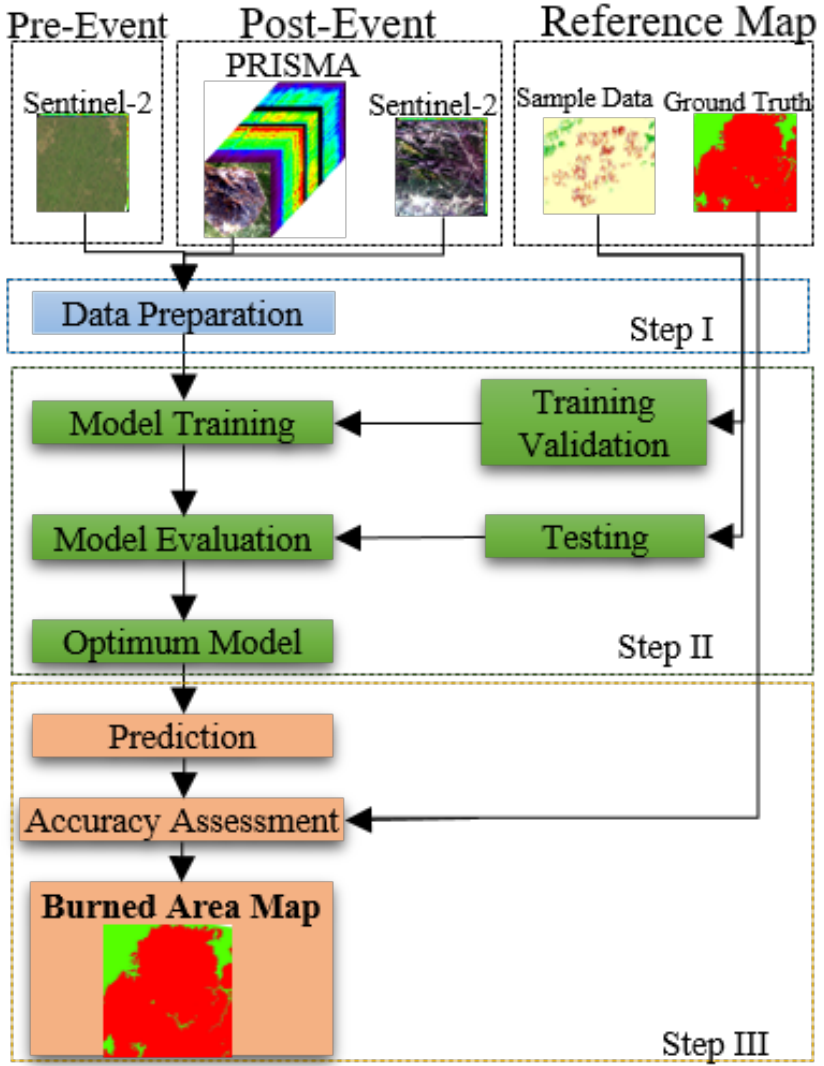
Figure 1. Overview of the general framework for the burned area mapping.